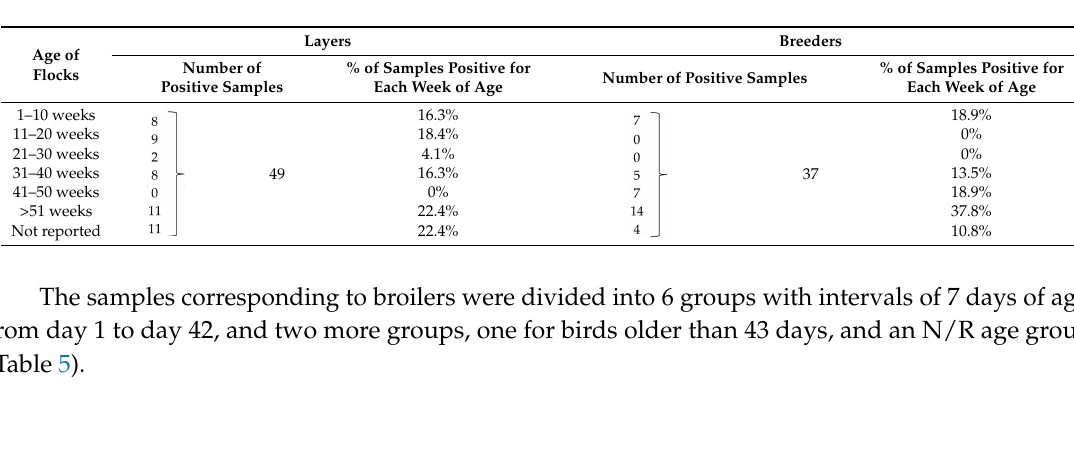
% of Samples Positive for Each Week of